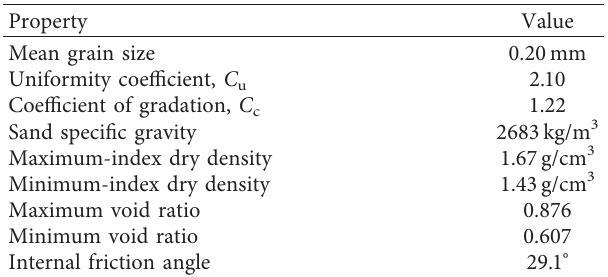
Table 2: Mechanical properties of sand samples used in laboratory